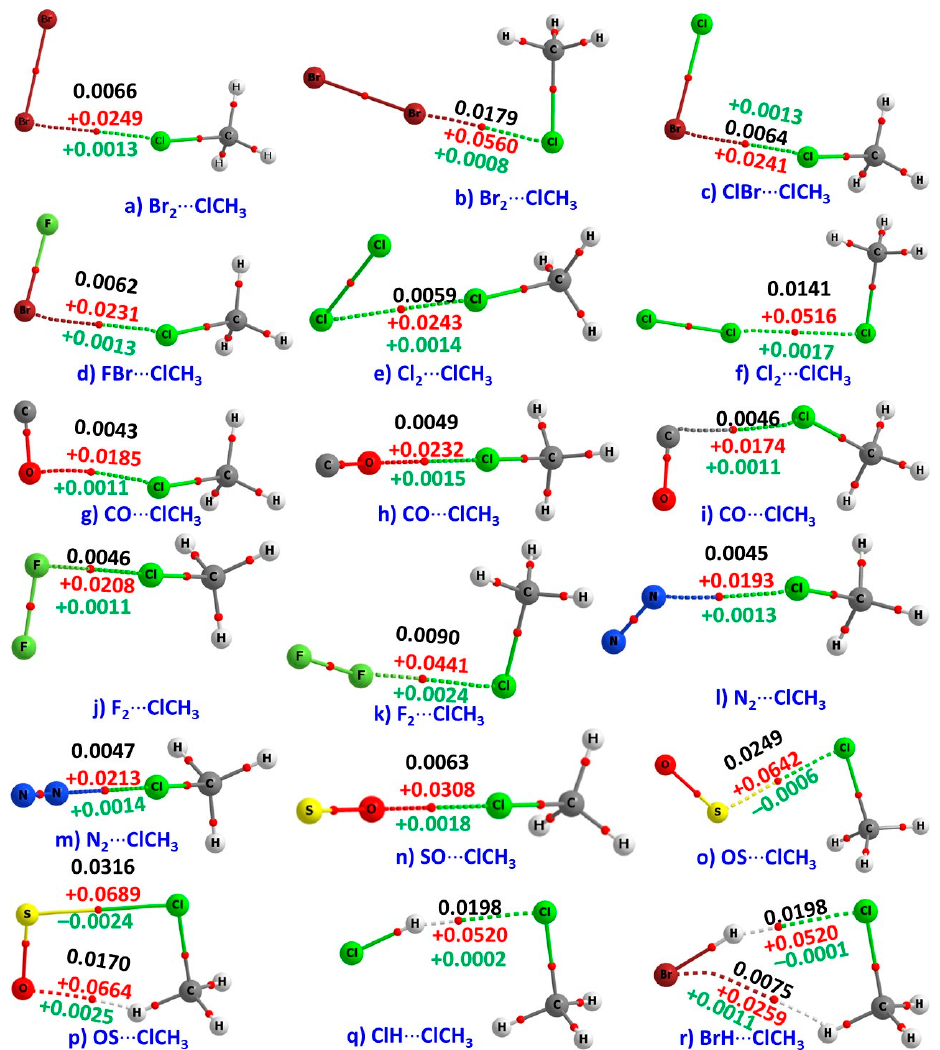
Figure 3. MP2 / aug-cc-pVTZ calculated quantum theory of atoms in molecules in molecules (QTAIM) molecular graphs of the 18 binary complexes of CH 3 Cl studied. The bond paths (solid and dotted lines) and the bond critical points (bcps) (tiny red spheres) are shown between the atomic basins. The charge density ( ρ b /a.u,), the Laplacian of the charge density ( ∇ 2 ρ b /a.u.), and the total energy density ( H b / a.u.) at the bcps of the intermolecular interactions are shown in black, red, and green fonts, respectively.